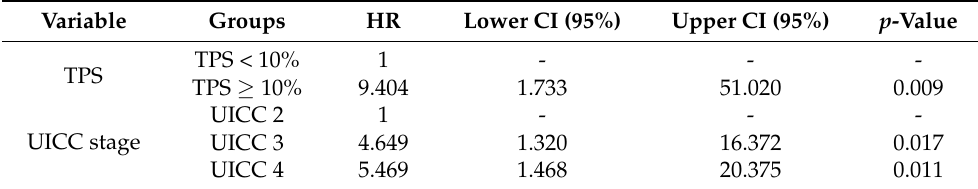
Figure 3. Kaplan-Meier survival analysis, stratified for Tumor Proportion Score. Survival data of a subset of 104 patients with available follow-up information were compared using Kaplan-Meier curves and log-rank testing. While at a Tumor Proportion Score (TPS) cut-off value at 1% no significant differences were observed ( A ), at a 10% ( B ) and 25% ( C ) cut-off, median survival was significantly worse in patients with high PD-L1 expression and six times lower than of those with lower expression ( p < 0.001, 0.4 years vs. 2.2 years for both analyses). Table 4. Multivariate survival analysis (Cox regression